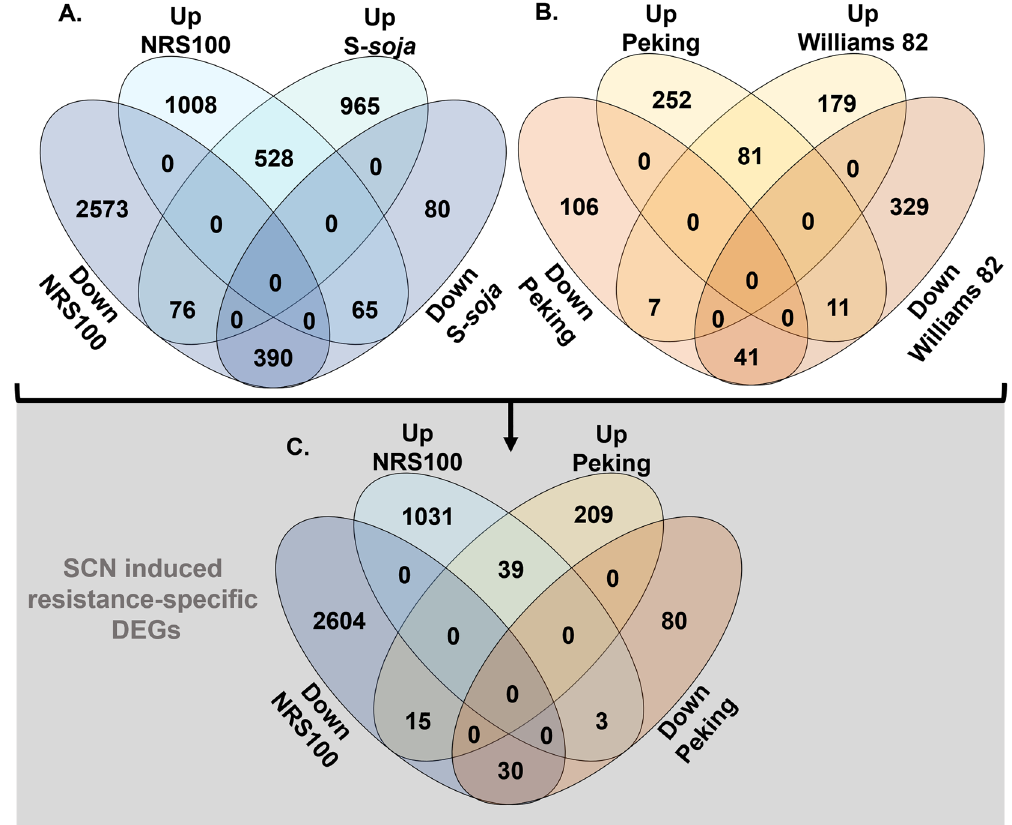
Figure 2. ( A ) Comparison of DEGs for SCN susceptible and SCN resistant G. soja genotypes. ( B ) Comparison of DEGs for SCN susceptible and SCN resistant G. max genotypes. Shared responses from susceptible and resistant genotypes from the same species were eliminated to produce a comparison of resistance-specific associated genes. ( C ) Comparison of resistance-specific genes between Peking and